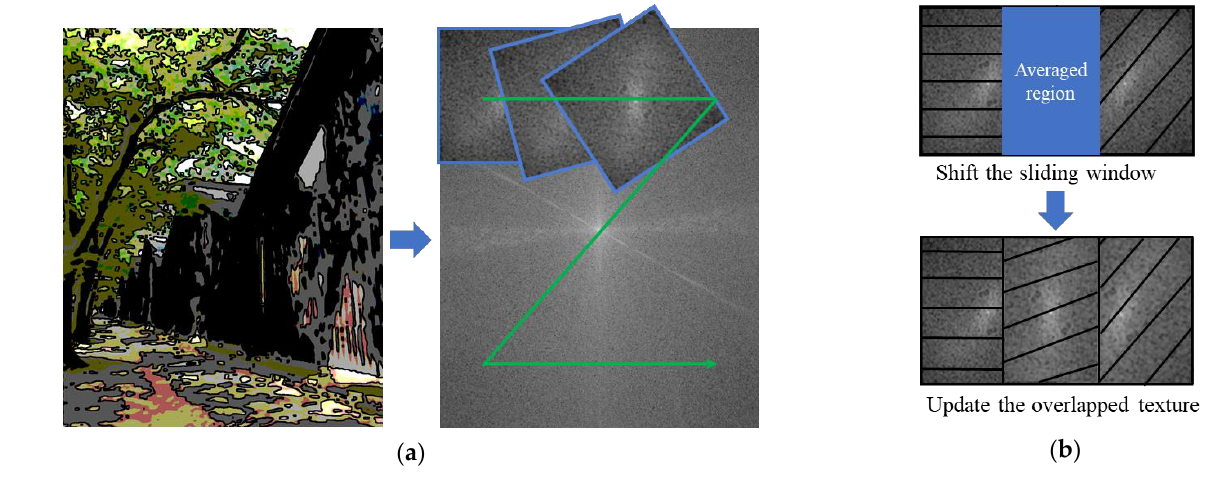
Figure 10. Frequency domain texture guided color information fusion, ( a ) transfer the edge enhanced image to FFT domain, ( b ) shift the sliding window and update the value in FFT domain based on phase angle.